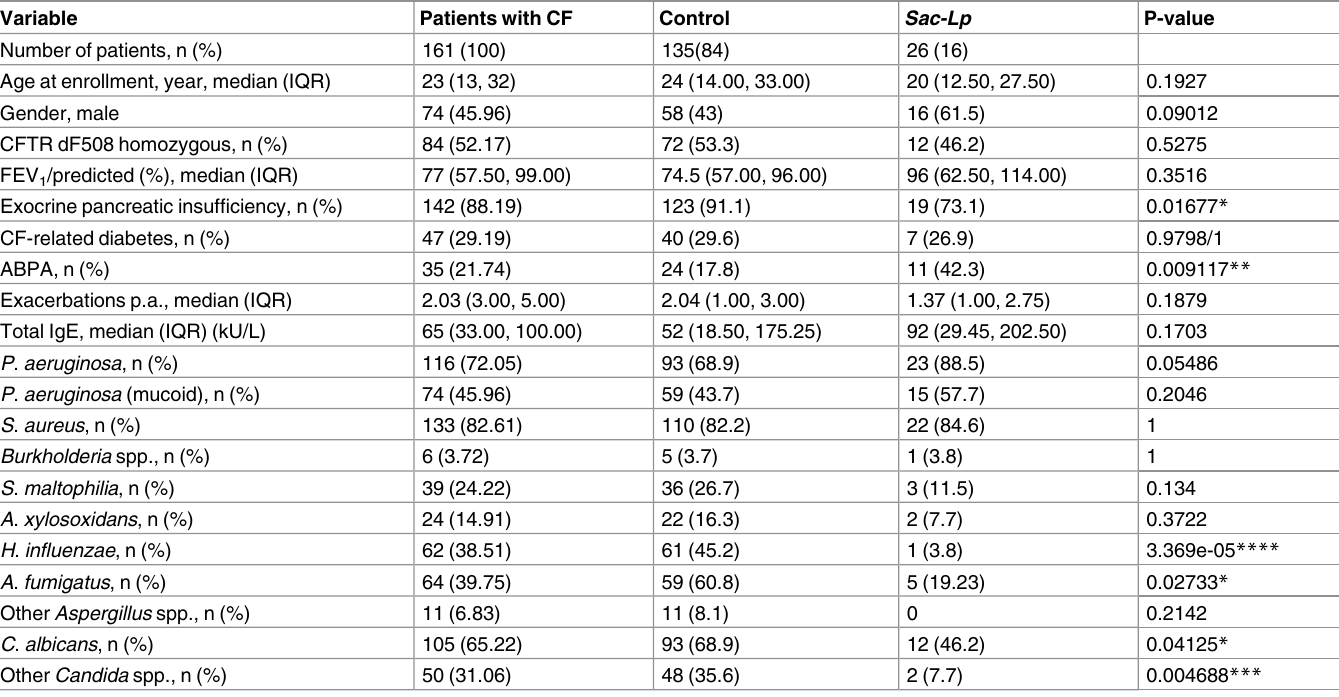
Table 1. Baseline characteristics of patients with CF without (control) and with ( Sac-Lp ) Sac-Lp colonization (total n = 161